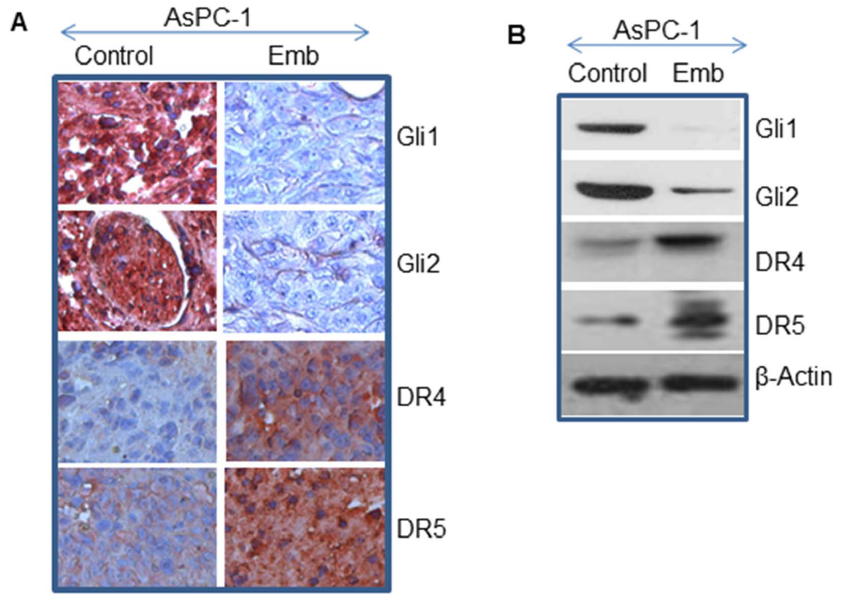
Figure 7. Effects of embelin on the expression of Sonic hedgehog pathways, and TRAIL-R1/DR4 and TRAIL-R2/DR5. (A), Immunohistochemistry was performed to measure the expression of Gli1, Gli2, DR4 and DR5 in tumor tissues isolated from control and embelin- treated mice. (B), Western blot analysis was performed to measure the expression of Gli1, Gli2, DR4 and DR5. The b -actin was used as a loading control.